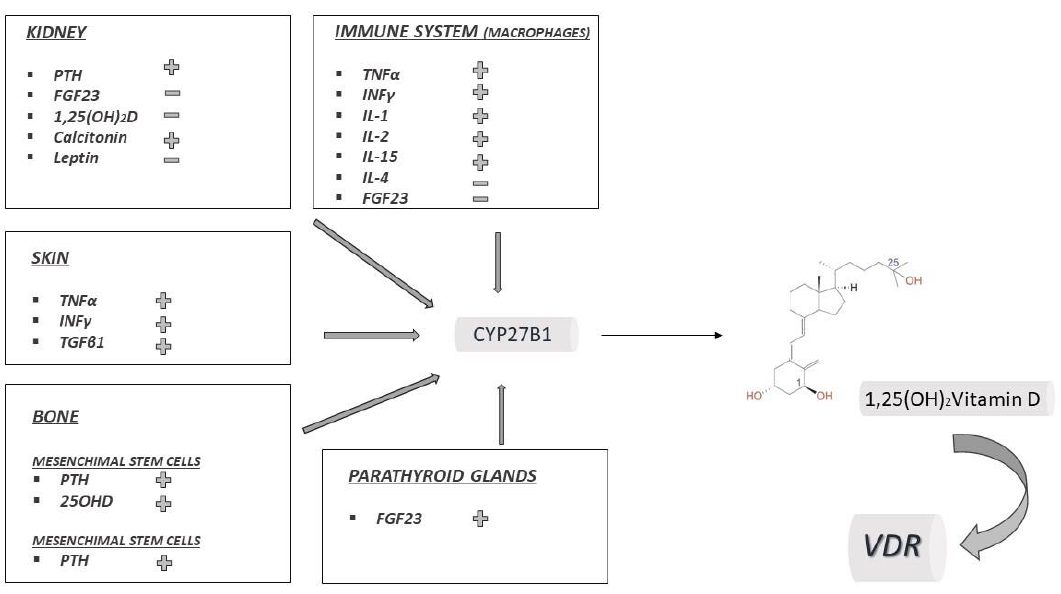
Figure 2. Tissue specific regulation of CYP27B1. In each box factors that stimulate ( + ) or inhibit ( − ) CYP27B1 are represented.